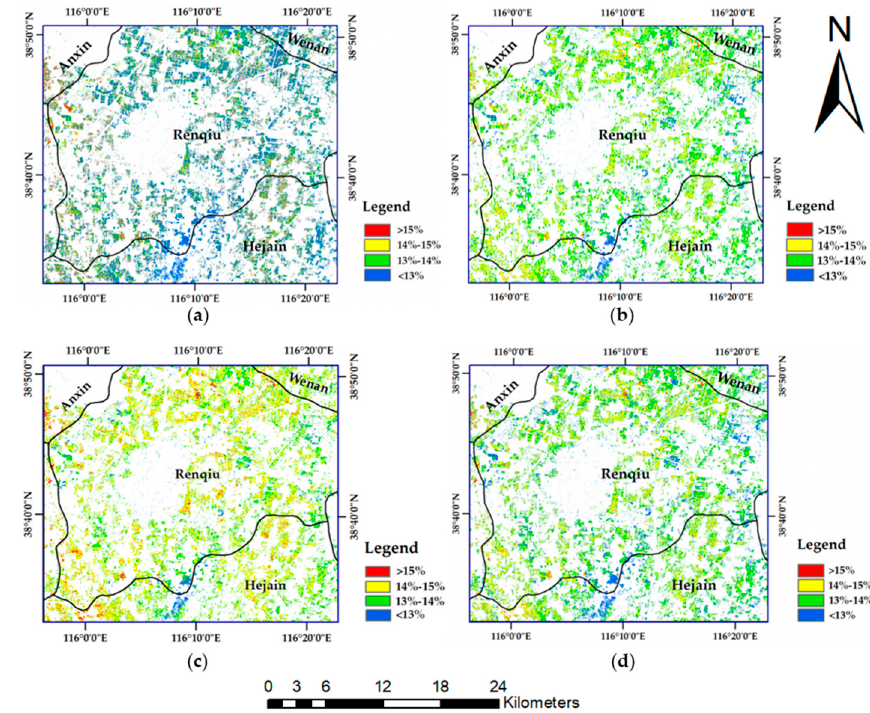
Figure 12. Spatial distribution of the grain protein content. ( a ) GPC LNC spatial distribution map. ( b ) GPC LNA spatial distribution map. ( c ) GPC PNC spatial distribution map. ( d ) GPC PNA spatial distribution map.